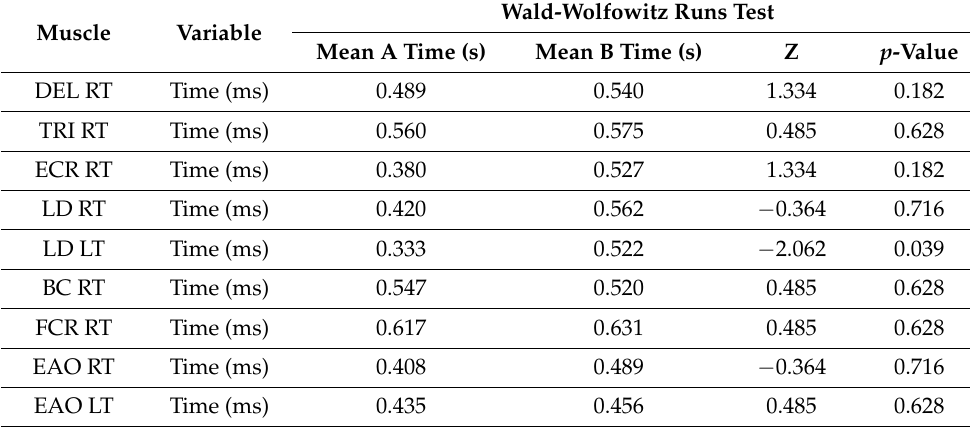
Table 1. Statistical analysis (Wald–Wolfowitz runs test) based on the comparison of the mean time of all attempts performed by selected muscle groups in response to a visual stimulus in category A and B fencers